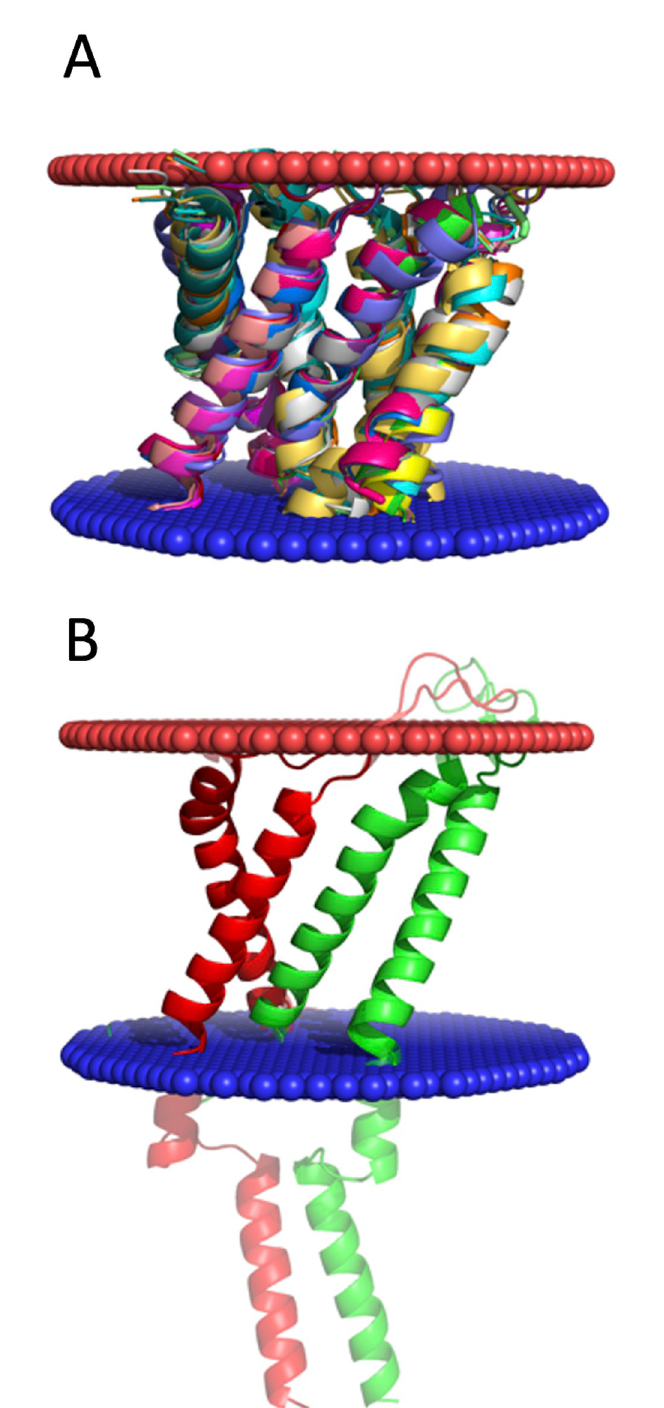
Fig 2. Example of the structure cluster. (A) The cluster consists of 15 binary interactions between transmembrane portions of the protein structures, each having two anti-parallel helices. All proteins in the cluster, from which these interfaces were extracted, were GO annotated as part of an ion channel. (B) The cluster’s representative structure contains transmembrane segments of chains A (red) and B (green) from 2wcd with extramembrane parts (not included in the dataset) blurred for clarity. The extra- and intra-cellular sides of the membrane are in red and blue, respectively. The cluster has an average RMSD 1.64 Å . The most distant cluster members are chains A and B of PDB 6ctd and chains C and D of PDB 4y7k with RMSD 3.12 Å